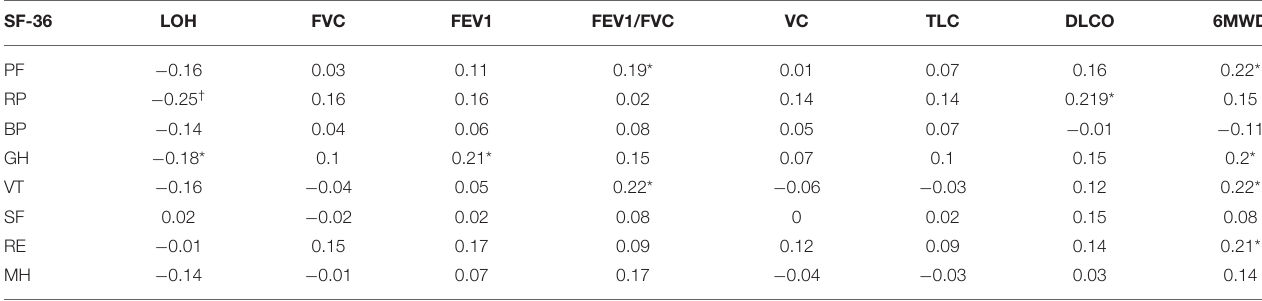
TABLE 3 | Correlations among HRQoL, length of hospitalization, pulmonary function, and 6MWD at the nearly 1-year